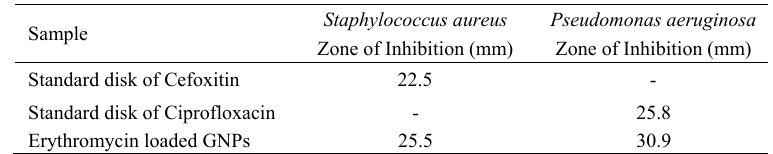
Table 3. Inhibitory zone diameters